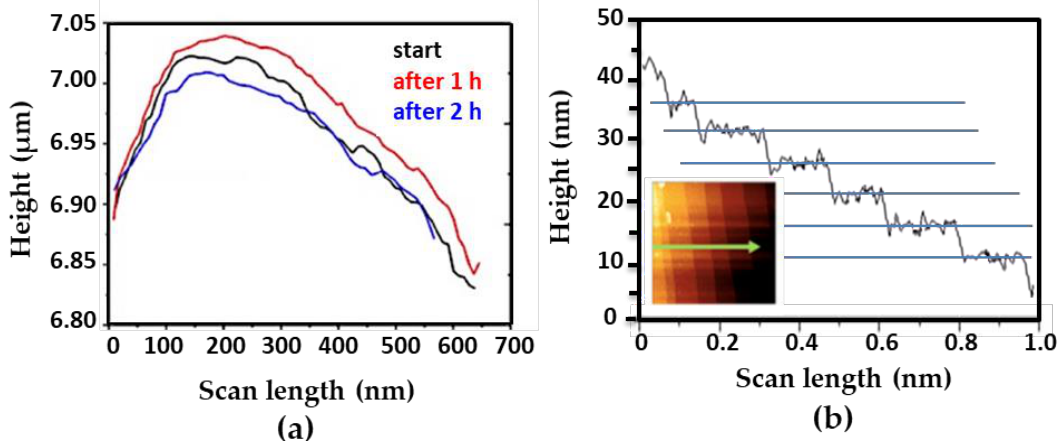
Figure 6. Typical height profiles of ( a ) a microMOF ( − ) crystal upon incubation in PBS pH = 7.4 up to 2 h and ( b ) a microMOF (+) crystal upon incubation in PBS pH = 5.4.